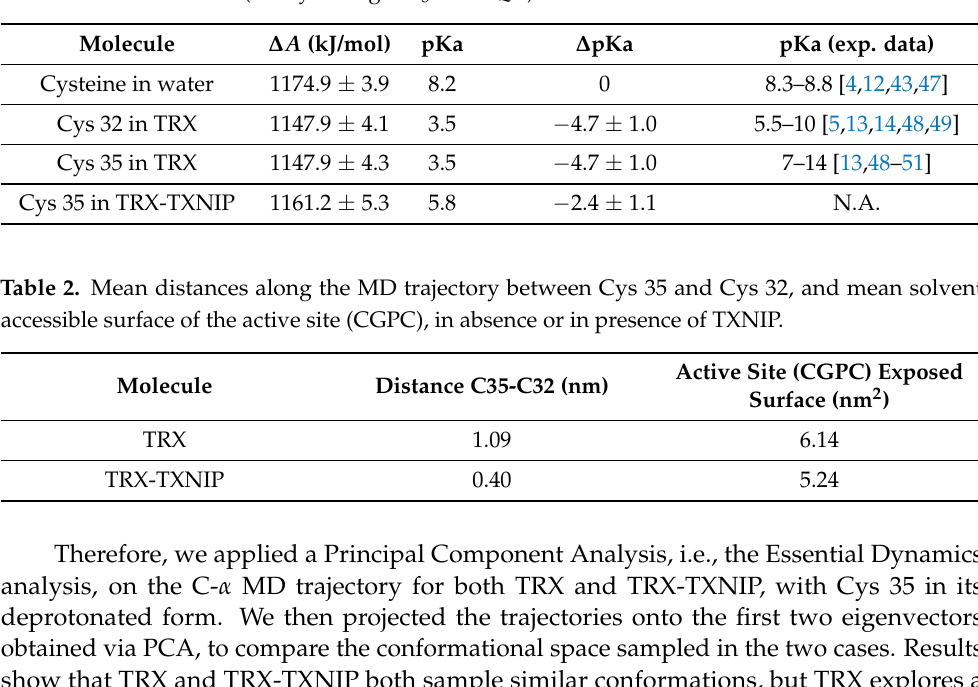
Table 1. Helmholtz Free Energy change and pKa for Cysteine in water, Cys 32 in TRX, and Cys 35 in TRX and in TRX-TXNIP (always using CH 3 SH as QC).